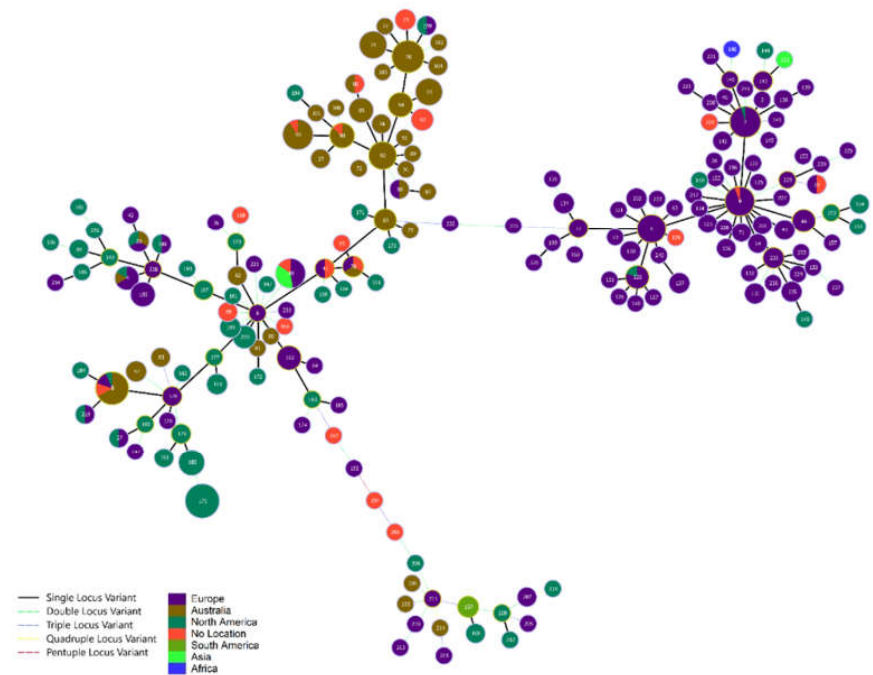
Figure 1. Minimum spanning tree of E. rhusiopathiae MLST scheme created from sequence of genes pta , galK , purA , ldhA , recA , gpsA, and prsA . Two major single locus variants (SLVs) consisting of a European group of isolates and a second SLV of isolates from Australia and the Americas.